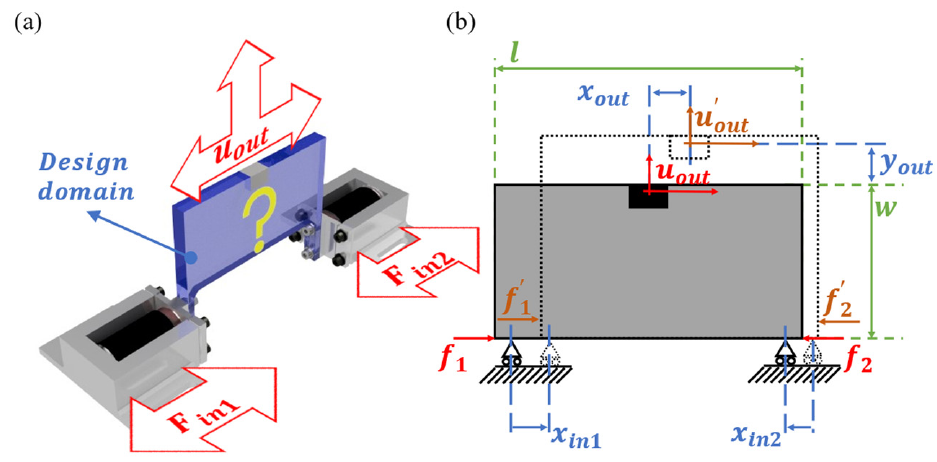
Figure 2. ( a ) Schematic illustration of a 2-DOF compliance set; ( b ) Simplification of the design domain and boundary conditions.